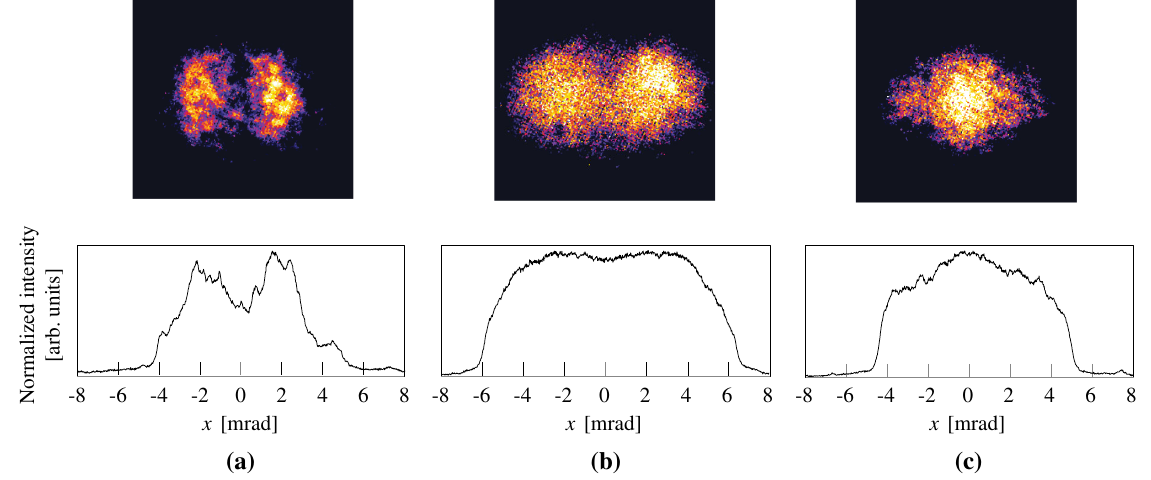
FIG. 7. Observed ICS 2nd and 3rd harmonics at MCP with the laser parameter 0 . 5 < a L < 0 . 7 with: (a) narrow-band transmission through 20 μ m Au foil giving the characteristic shape of the ICS 2nd harmonic; (b) transmission through 250 μ m Al foil showing the superposition of 2nd and 3rd harmonics; and (c) 1000 μ m Al foil effectively transmitting only 3rd and higher harmonics. Contrast has adjusted for the rendered color MCP image. Lineout profiles correspond to the line y ¼ 0 , giving the normalized intensity distributions measured.